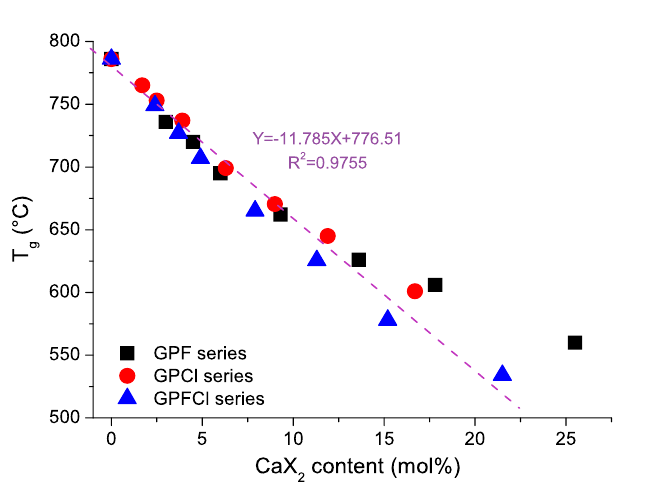
Figure 1. The percentage of the retained chloride in the initial glasses plotted against the as-designed CaCl 2 content for GPFCl and GPCl glass series. Note where error bars are not shown they are smaller than the data point.